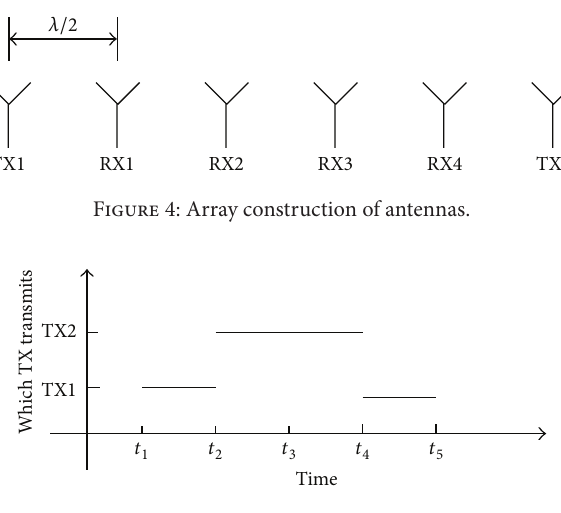
Figure 5: TDM scheme: 2 transmitters transmitting at